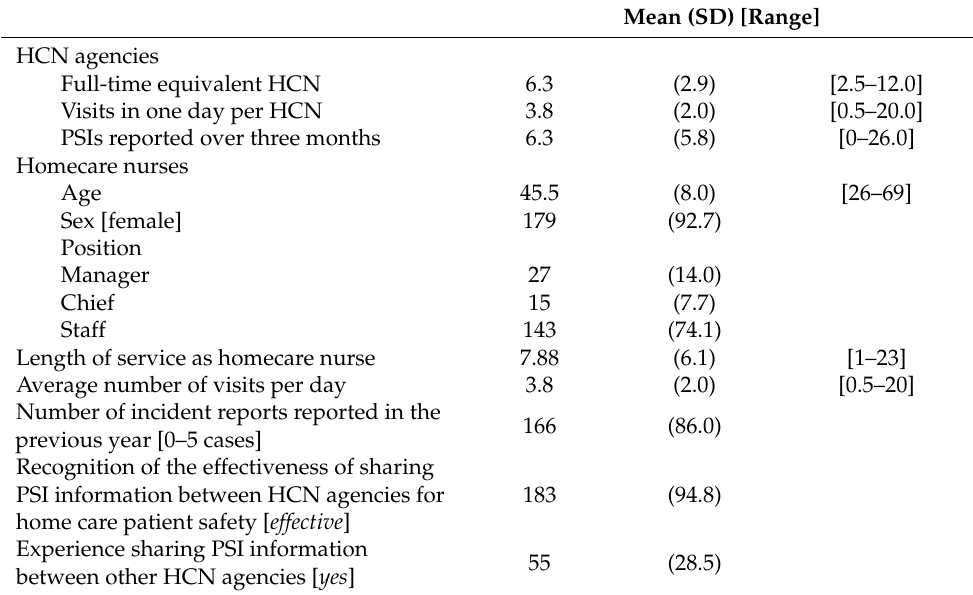
Table 1. Characteristics of homecare nursing (HCN) agencies and homecare nurses. (HCN agencies = 27, Homecare nurses =